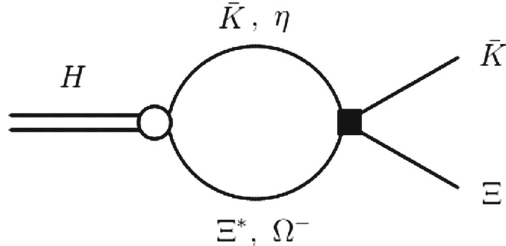
Fig. 2 Decay of H → ¯ K (cid:3) through the creation and re-scattering of the ¯ K (cid:3) ∗ and η(cid:2) pairs